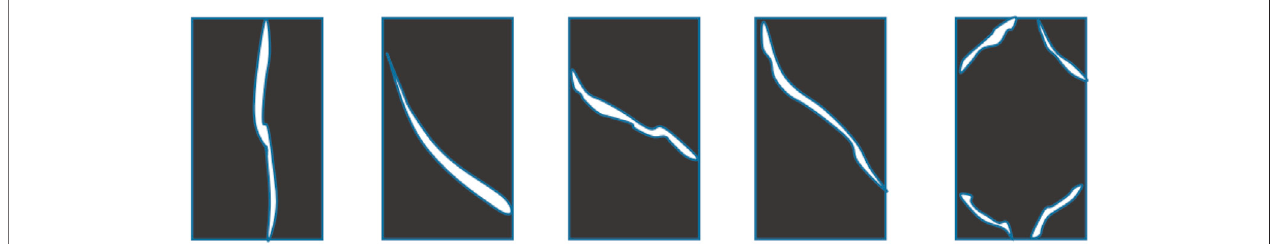
FIGURE 3 | Simpli fi ed failure model of specimens 1 –